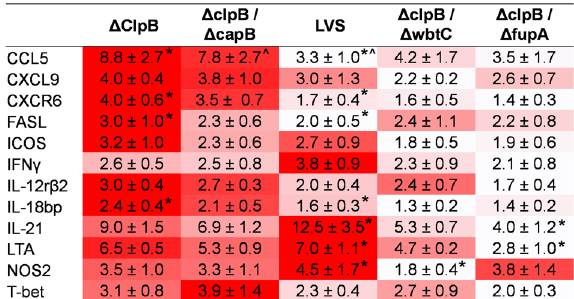
Fig. 4 Relative gene expression of a working panel of correlates of protection in PBLs suggests a hierarchy of vaccine ef fi cacy. BMM Φ from Fischer rats were infected with LVS and co-cultured with PBLs obtained from naive or vaccinated rats, as indicated. After 2 days of co-culture, PBLs were collected and analyzed for relative gene expression. Semiquantitative analyses of gene expression were performed using a custom array as described in “ Methods ” . Fold changes were calculated in comparison to naïve cells and data shown are averages of fold change ± standard error of the mean (s.e.m.) calculated from four independent experiments of a similar design. The heat map shown was generated within each gene across vaccine groups; darker colors indicate higher upregulation, while white indicates lower upregulation, within each gene. Matching symbols indicate signi fi cant differences in comparison to values observed for LVS-immune cells ( P <